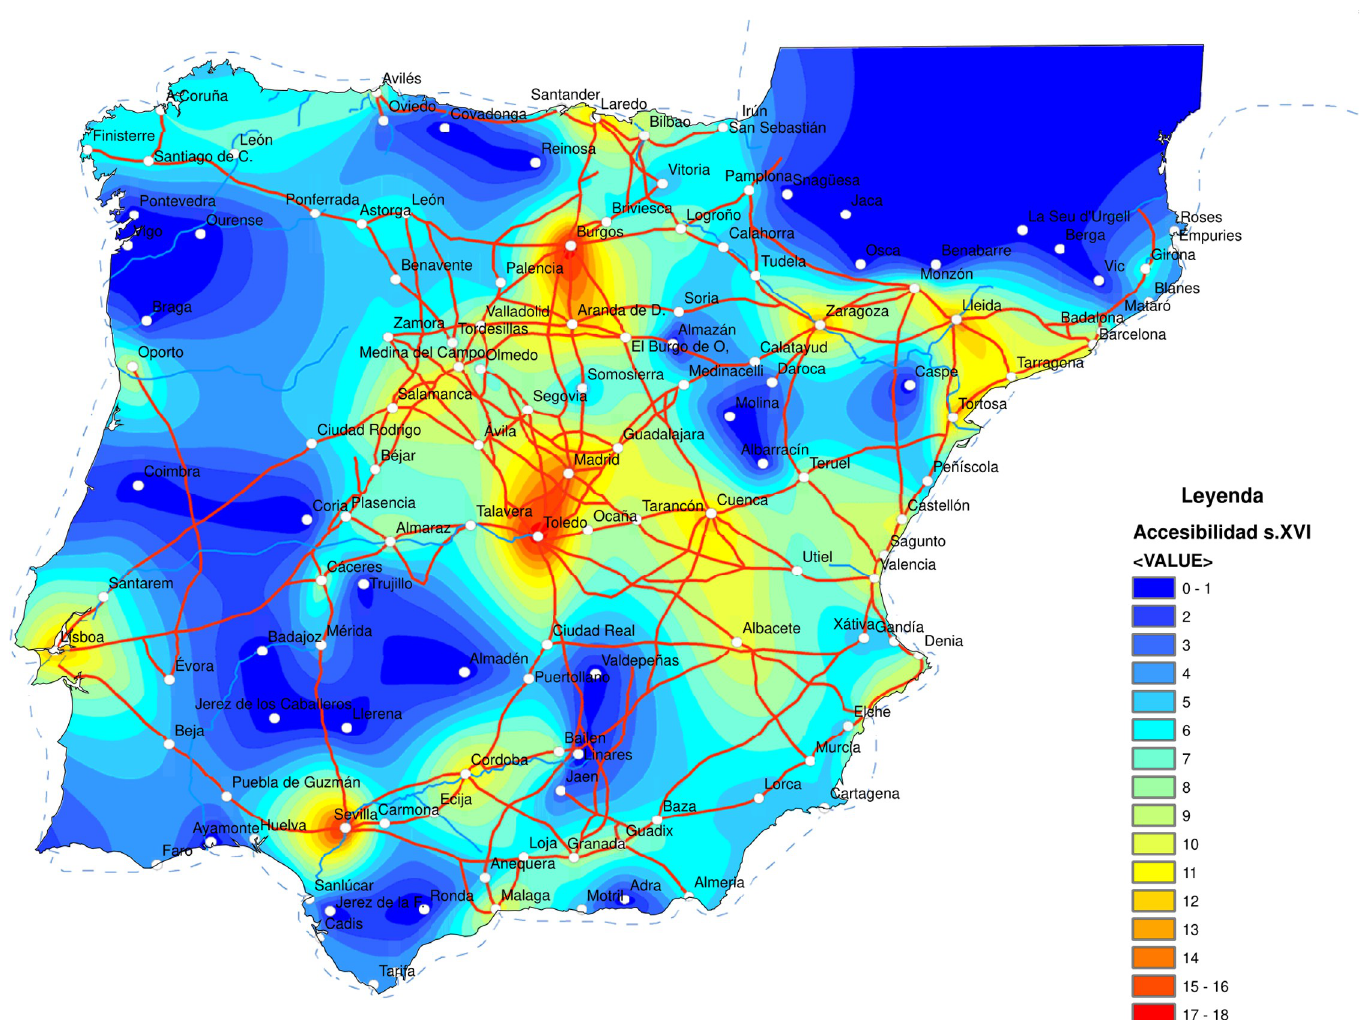
Fig 3. Accessibility in the 16 th century. Source: Reprinted from Carreras Monfort and Soto (2010) under a CC BY license, with permission from UPC University Press, original copyright 2010.